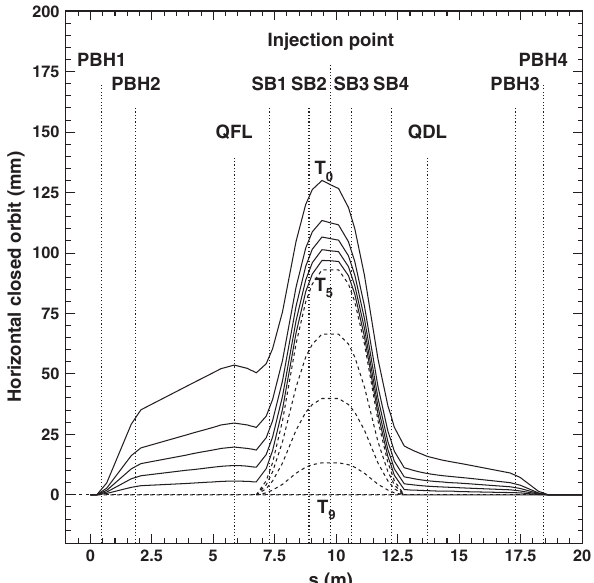
FIG. 6. Excitation field forms of QDTs required for correcting beta function beating in the case of 150 π mm mrad transverse R ð B 0 =B ρ Þ ds painting, where k 1 is defined as y